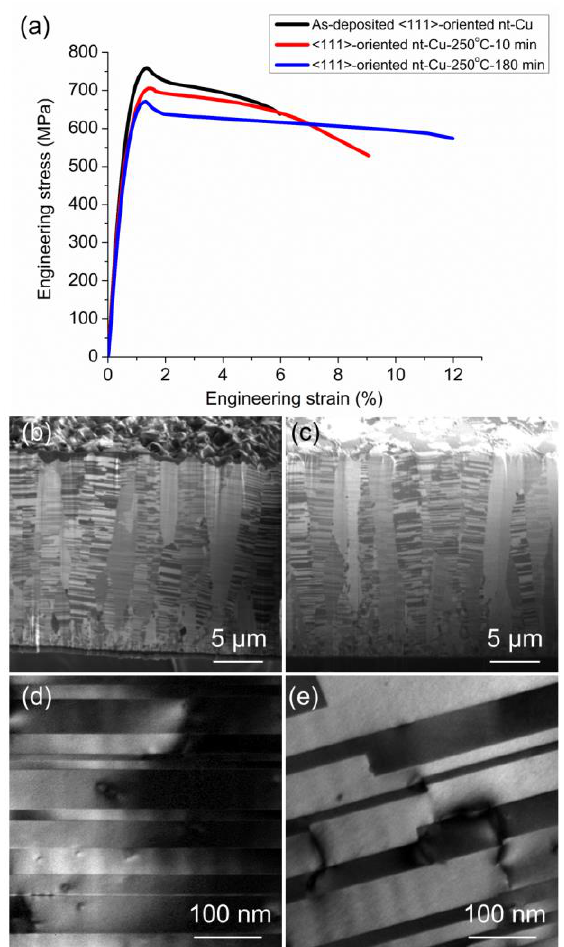
Figure 5. ( a ) The stress – strain curve of <111>-oriented nt-Cu foils before and after annealing at 250 °C for 10 and 180 min. The cross-sectional ion images of nt-Cu after annealing at 250 °C for ( b ) 10 min and ( c ) 180 min. ( d , e ) are the TEM images of <111> nt-Cu.